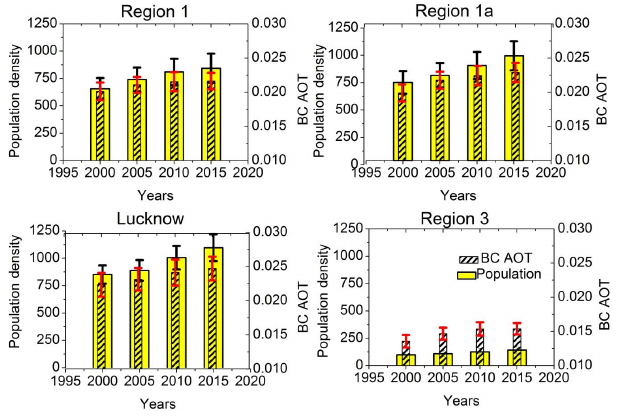
Figure 9. Region-wise population densities and BC AOT values (during August) for regions 1, 1a, Lucknow and region 3 during (2000–2015); vertical bars represent the corresponding 1 σ standard deviations